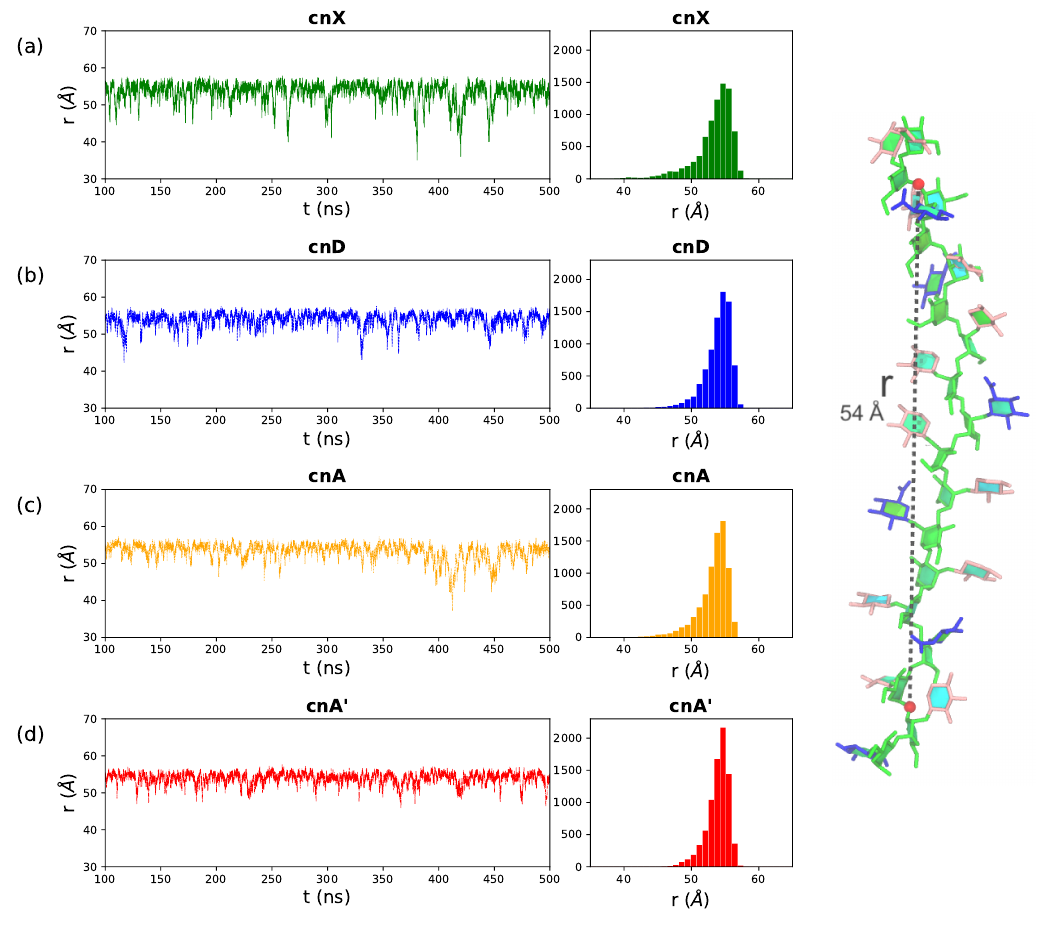
Figure 3. End-to-end distance, r , time series and corresponding histograms for the ( a ) cnX, ( b ) cnD, ( c ) cnA and ( d ) cnA’ GXM chains. The first 100 ns of simulation are considered equilibration and are not shown. Here r is defined to exclude the two terminal residues on either end of the chain, as the distance from O3 in the second linkage to O3 in the 16th linkage in the 18-mannose backbone—labelled for cnA in the image on the right. The residues and substitutions are coloured as follows: α DMan—green; β DGlcA—blue; β DXyl—pink; and